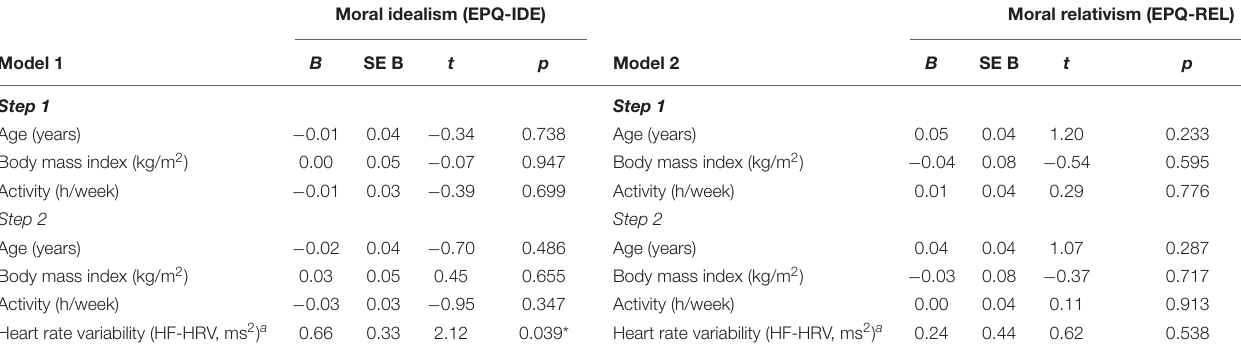
TABLE 2 | Association of moral idealism (EPQ-IDE) or moral relativism (EPQ-REL) with heart rate variability (HF-HRV). Moral idealism (EPQ-IDE) Moral relativism